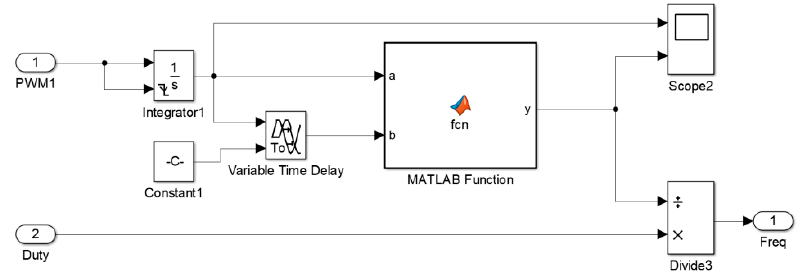
Figure 11. Internal structure of the frequency estimator.